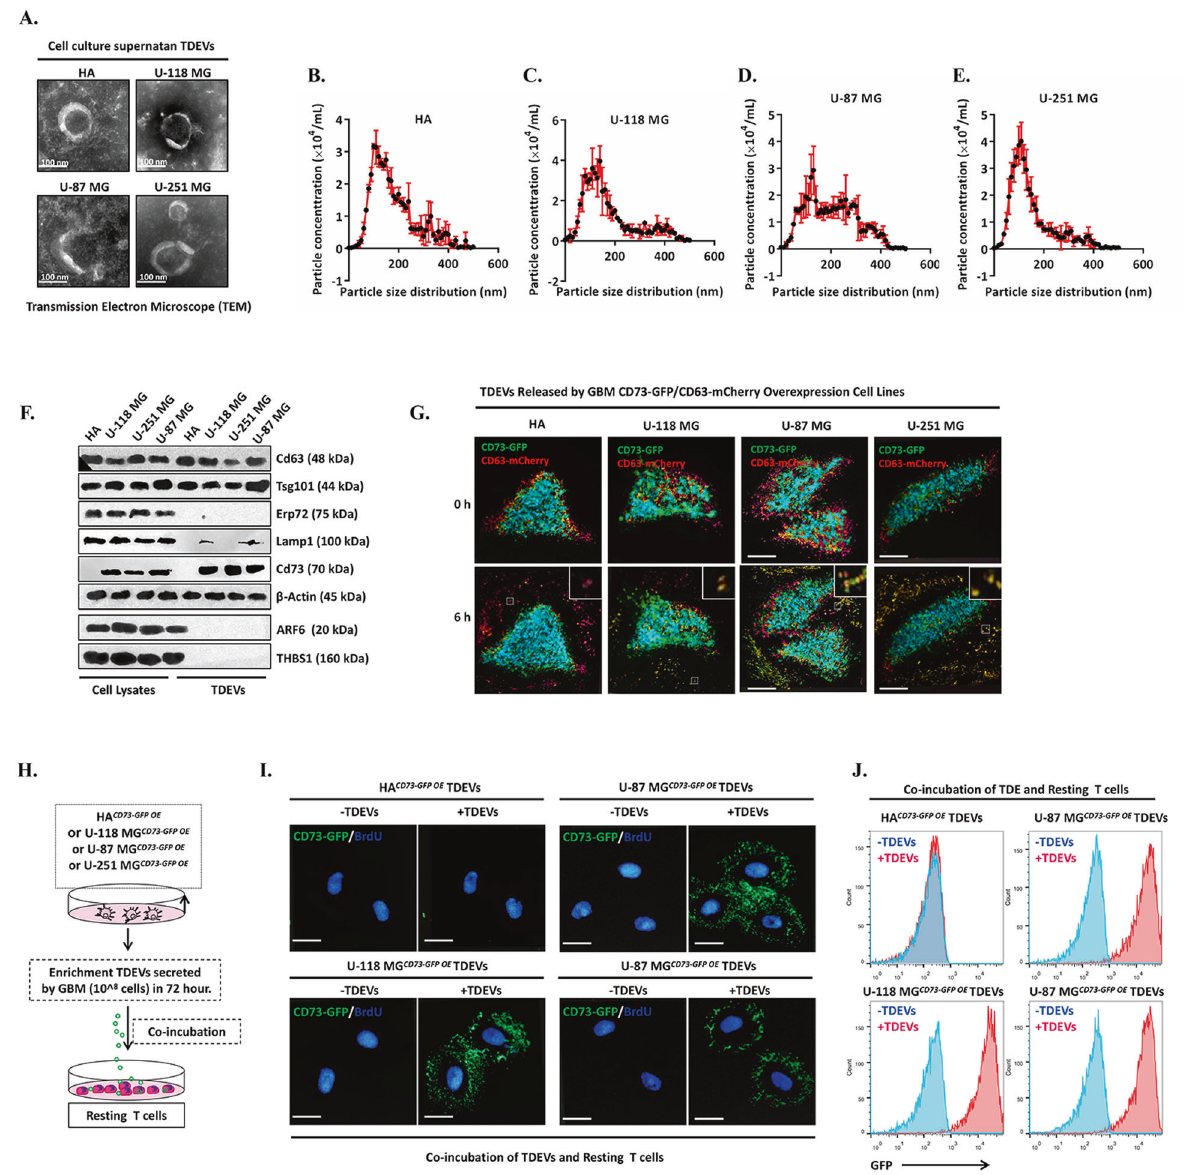
negative control marker (Erp72), lysosome negative control marker (Lamp1) and CD73 in cell lysates and TDEVs of HAs and U-118 MG, U-87 MG and U-251 MG cells. G Representative confocal microscopy images were used to visualise TDEV release within 6 h from HAs and the three GBM cell lines cotransfected with overexpression plasmids harbouring GFP-tagged CD73 and mCherry-tagged CD63. H Schematic diagram of the cocultivation experiment involving HA CD73-GFP OE , U-118 MG CD73-GFP OE , U-87 MG CD73-GFP OE , U-251 MG CD73-GFP OE and T cells. I Representative confocal microscope images of GFP-labelled nanovesicles taken up by T cells cocultured with HAs and U-118 MG, U-87 MG and U-251 MG cells before and after 12 h. J Representative fl ow cytometry diagram of GFP intensity on the surface of T cells cocultured with HAs, U-118 MG cells, U-87 MG cells. Data are shown as the mean ± SD; t test, * p < 0.05 and ** p < 0.01 compared to the GBM group. All data are from three independent